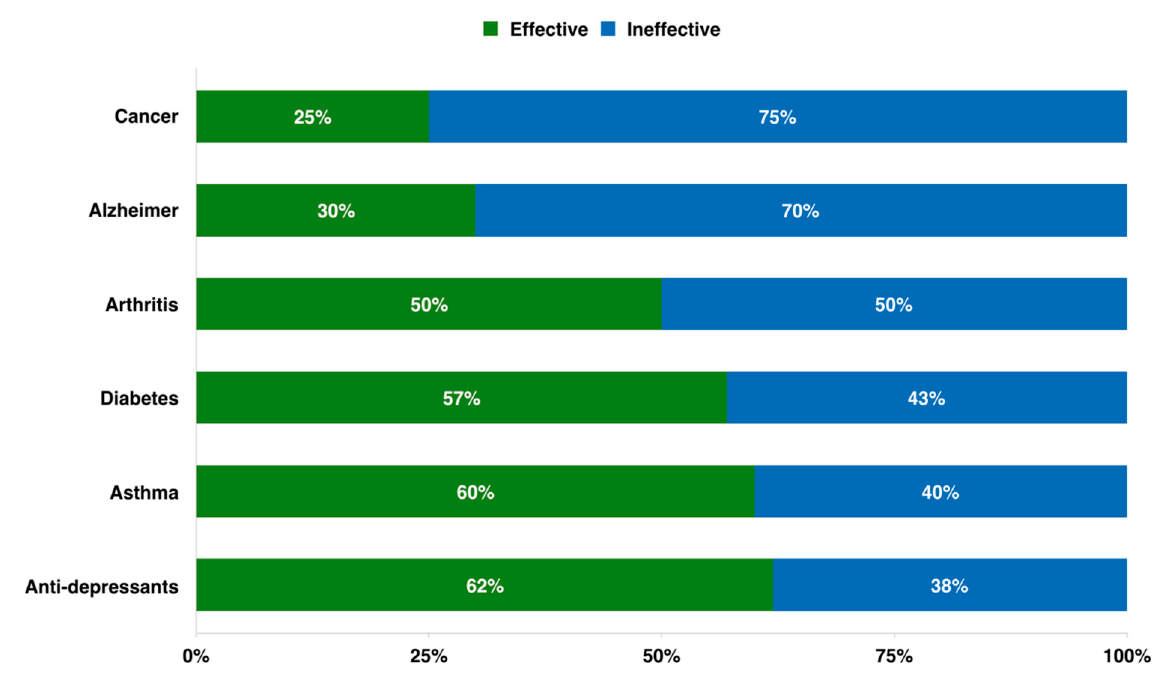
Figure 4. Estimate of Ineffective Drug Responses. Estimates show that 75% of anti-cancer drugs, 70% of Alzheimer drugs, 50% of anti-arthritis drugs, 43% of anti-diabetic drugs, 40% of asthma drugs, and 38% of antidepressants are ineffective. Adapted from [39].